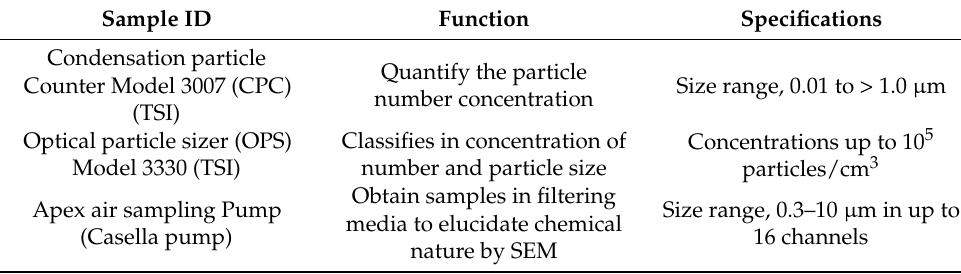
Figure 2. Sanding bench for abrasion and particle collection. Table 5. Instrumentation used in the measurement campaign.